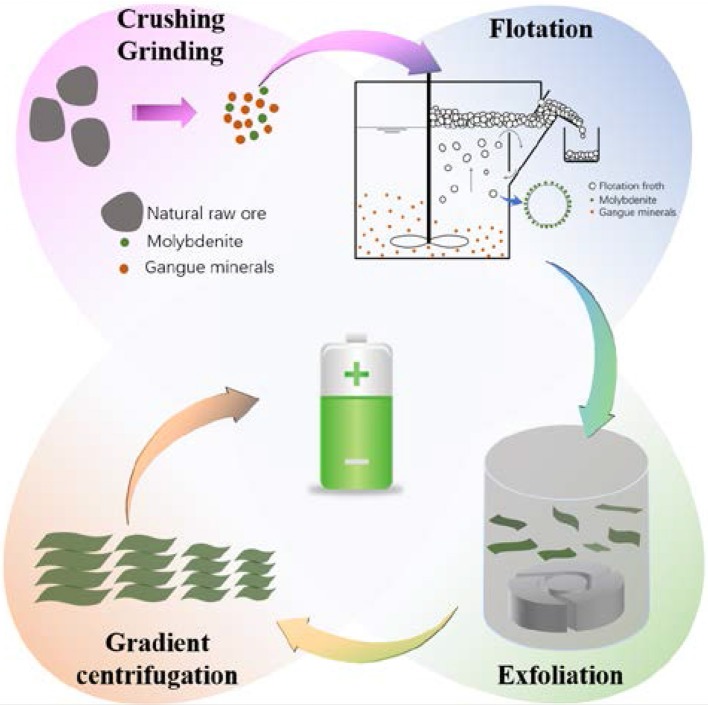
Schematic plan of hydro-refining process of natural raw ore.